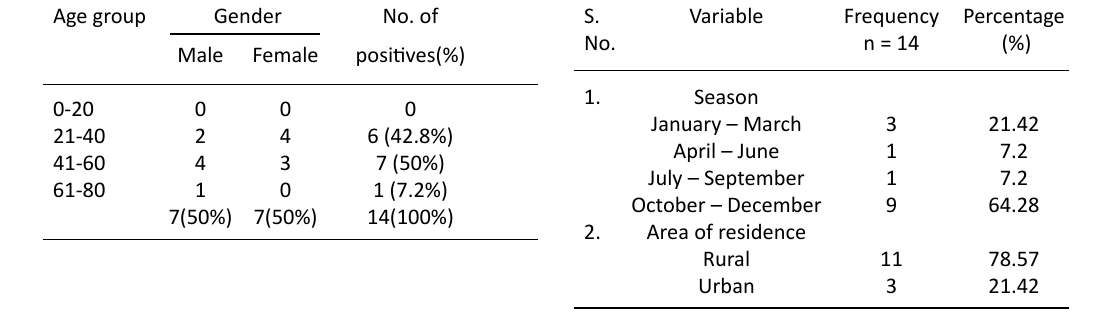
Table 4. Association between incidence of scrub typhus and related variables S.No Variable Scrub Typhus – Positive Chi Square P Value